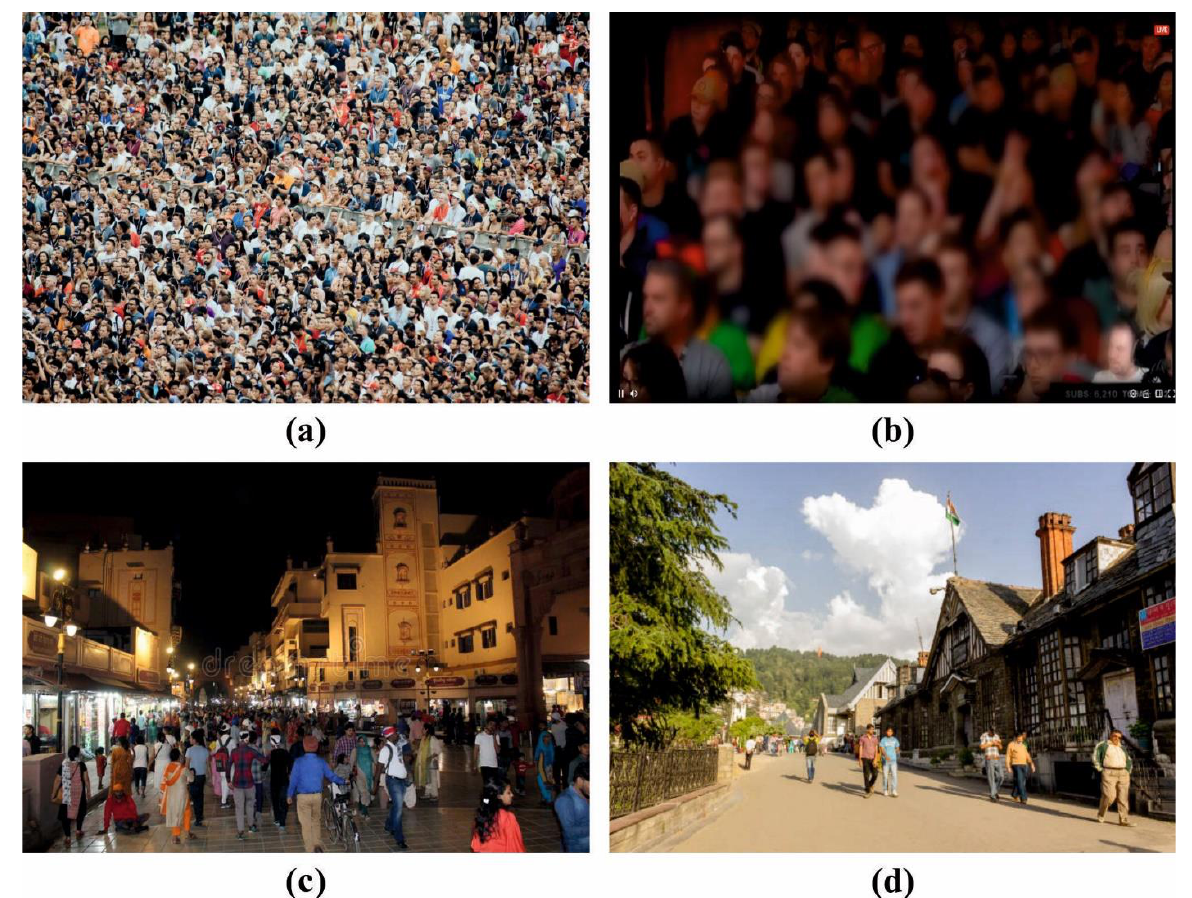
Figure 4. Sample Crowd Density Images. ( a ) Dense Crowd, ( b ) Medium Dense Crowd, ( c ) Sparse Crowd, ( d ) No Crowd.